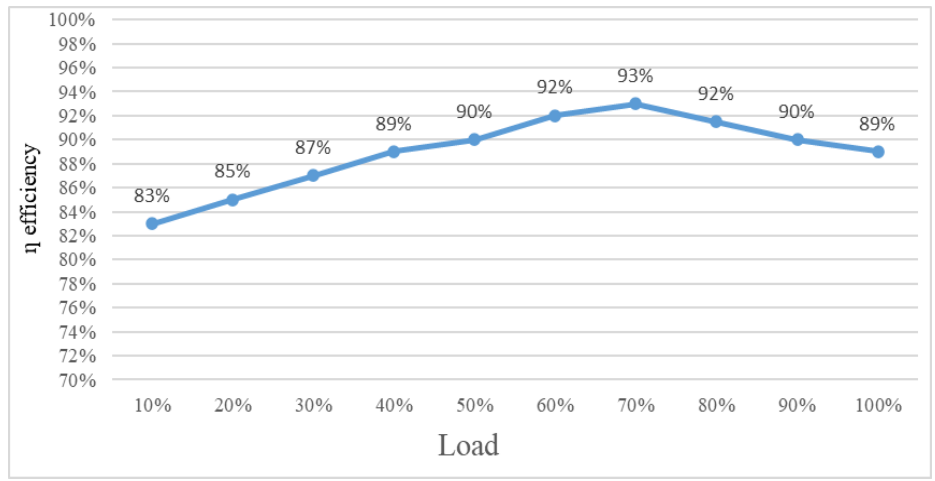
Figure 23. Measured battery voltage V B and current I B waveforms of the proposed hybrid converter operated in the utility line condition under step-load changes from I B = 2.4A to I B(max) = 12A.